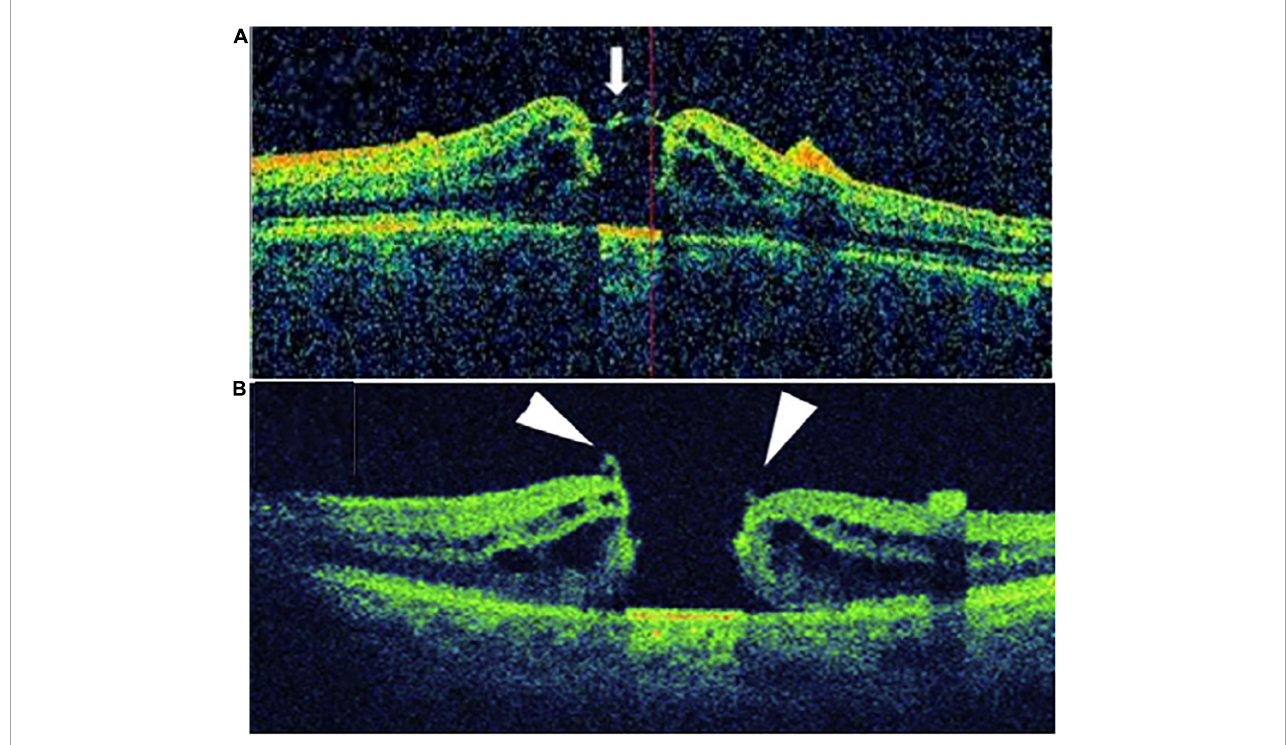
FIGURE2 Patients with RF were divided into two groups according to the location of the RF: (A) RF at the hole edge group (RFHE), (B) RF not at the hole edge group (non- RFHE).